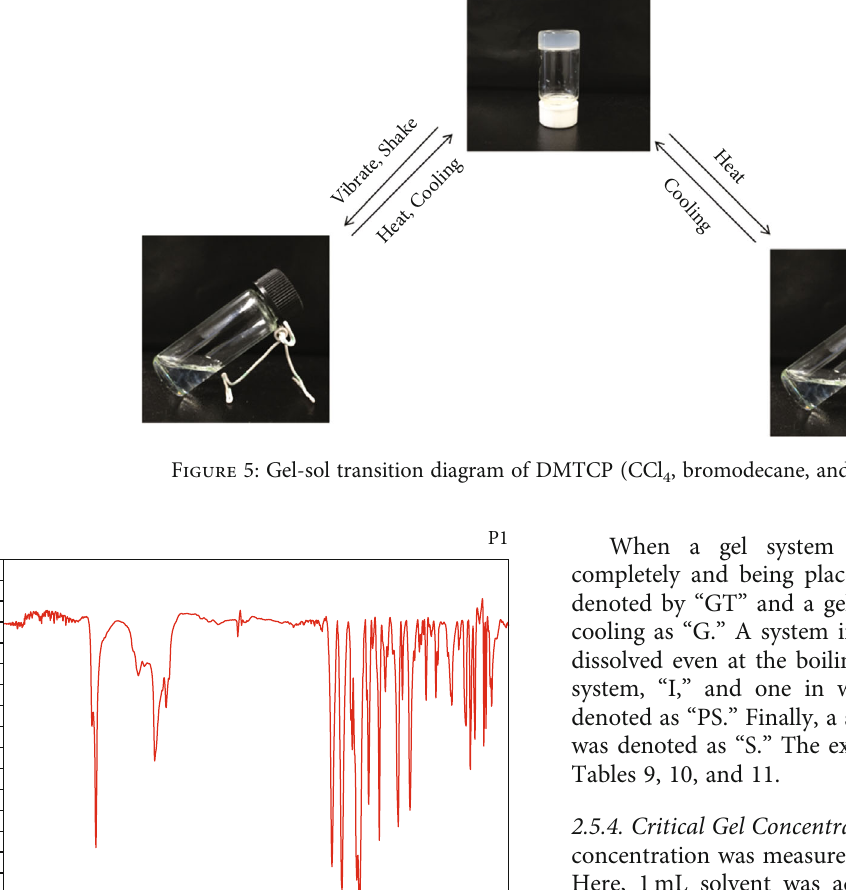
Figure 6: Infrared spectra of 6-(2,2 ′ :6 ′ :2 ″ -terpyridine-4 ′ -formamide) hexanoic